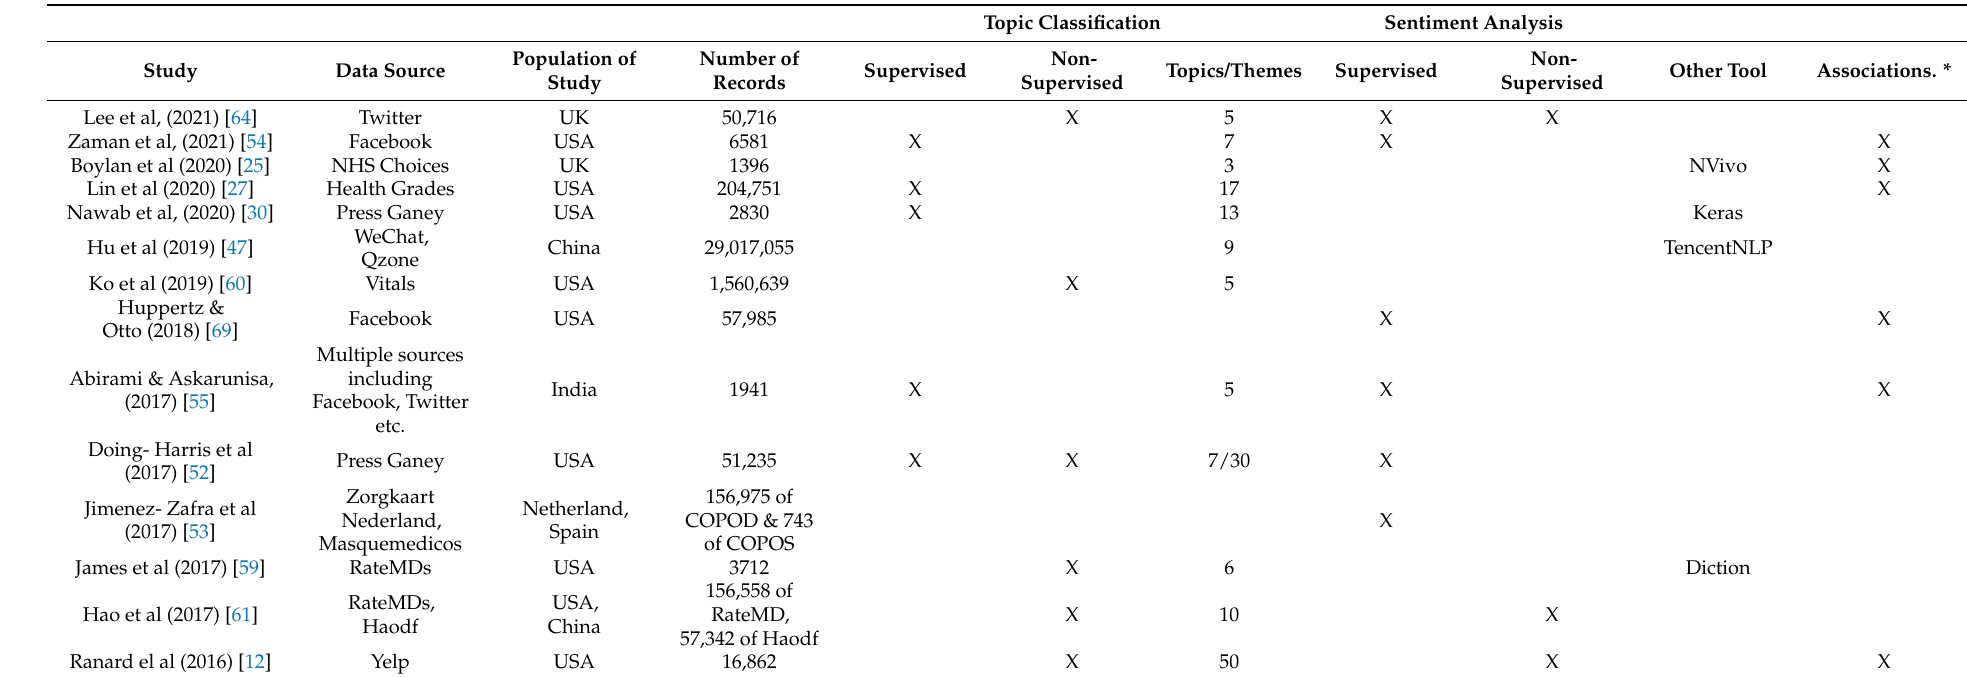
Table 1. Summary of Previous